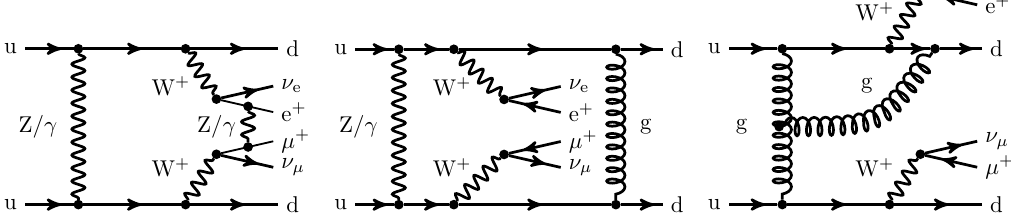
Figure 3. Sample one-loop level diagrams contributing to the process pp